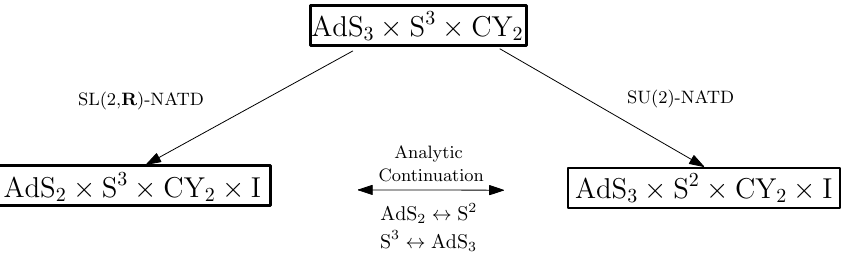
Figure 3 . Relation between the solution (2.17) and the solution obtained in [56] through SU(2)-